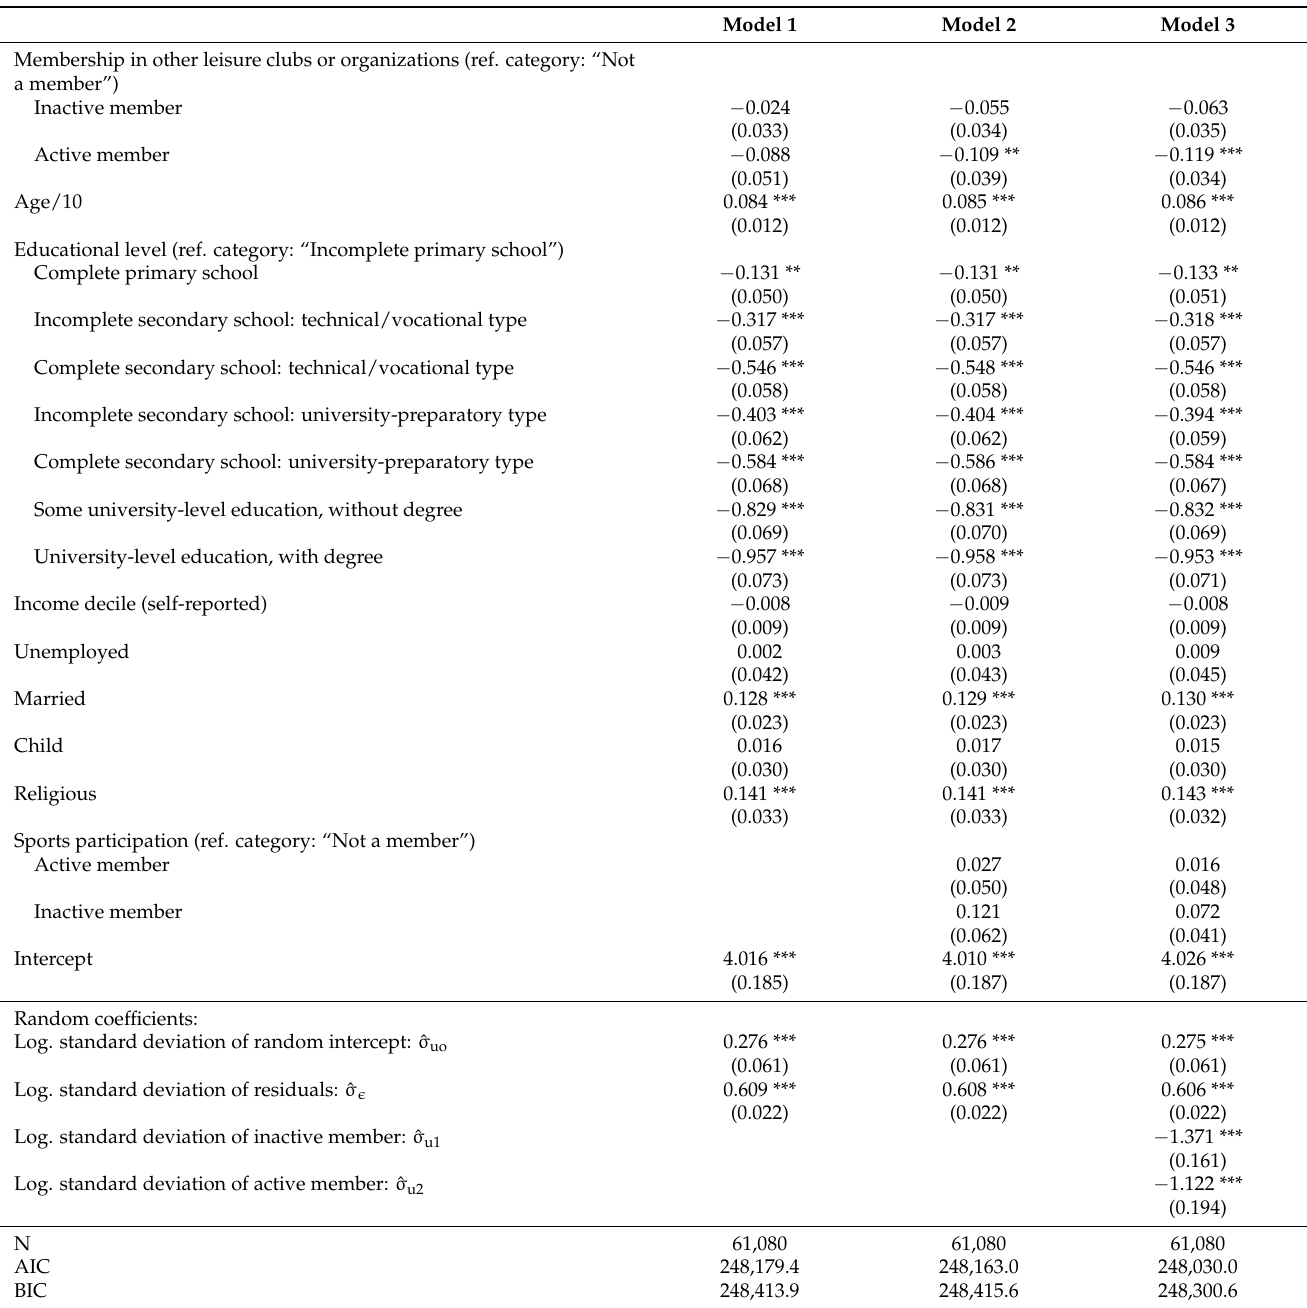
Table 4. The partial effects of sports participation and the other covariates on sexist gender ideologies. Random coefficient models based on female observations from 74 countries. Source: